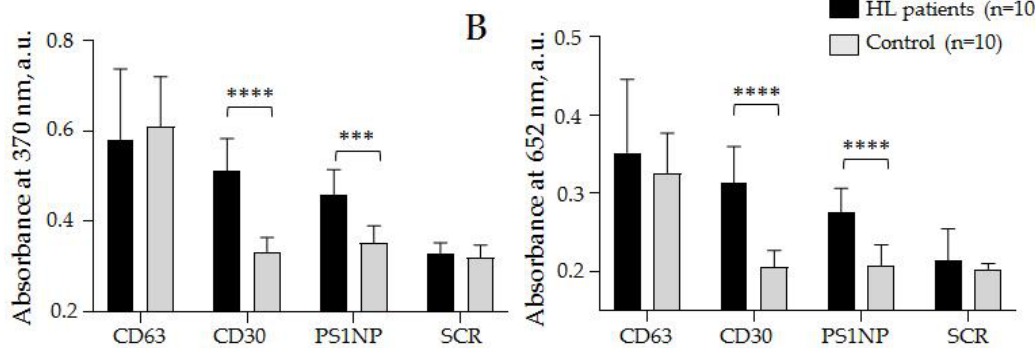
Figure 8. Relative quantification of CD30 + SEVs in the plasma of HL patients and healthy donors. CD63-specific (CD63) and scramble (SCR) aptamers were used in parallel as positive and negative controls, respectively. The absorbance was estimated at wavelengths of 370 nm ( A ) and 652 nm ( B ) and averaged within clinical groups. The statistical significance of the observed difference was evaluated with the nonparametric Mann–Whitney test (*** p < 0.0005 and **** p < 0.00005). The results (mean values and the standard deviation) obtained at 370 nm by the AuNP aptasensor with the CD30 aptamer: cHL patients 0.51 ± 0.07 a.u., donors 0.33 ± 0.03; PS1NP aptamer: cHL patients 0.46 ± 0.05 a.u., donors 0.35 ± 0.04 a.u.; with CD63 aptamer: cHL patients 0.59 ± 0.11 a.u., donors 0.61 ± 0.09 a.u., and with scramble aptamer: cHL patients 0.33 ± 0.02 a.u., donors 0.32 ± 0.03 a.u. (Figure 8A). The results obtained at 652 nm by AuNP aptasensor with CD30: cHL patients 0.31 ± 0.05 a.u., donors 0.21 ± 0.02 a.u.; with PS1NP aptamer: cHL patients 0.28 ± 0.03 a.u., donors 0.21 ± 0.03 a.u., with CD63 aptamer: cHL patients 0.35 ± 0.09 a.u., donors 0.33 ± 0.05 a.u., and with scramble aptamer: cHL patients 0.23 ± 0.04 a.u., donors 0.18 ± 0.01 a.u. (Figure 8B). A statistically significant dif-